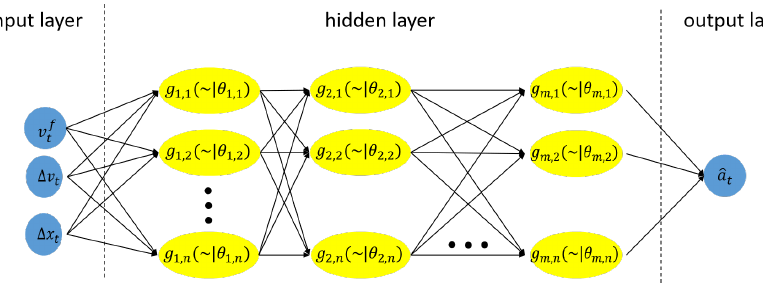
Figure 4. Neural network CF